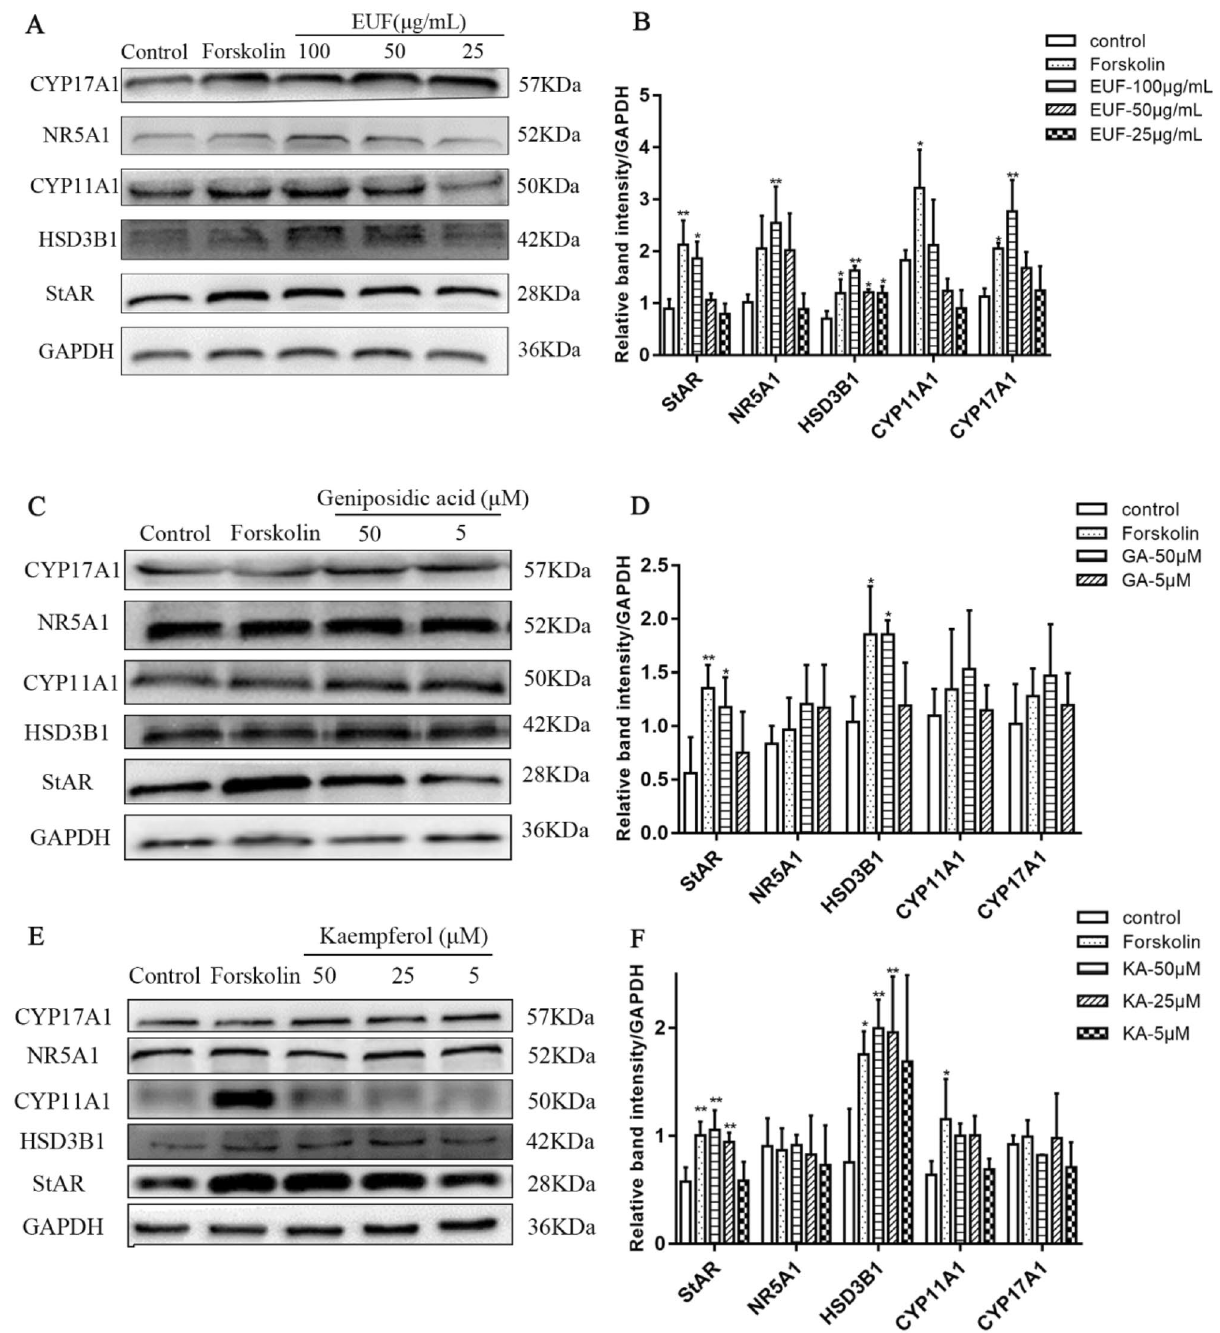
Figure 3. Effects of EUF extract ( A , B ), geniposidic acid ( C , D ), and kaempferol ( E , F ) on the protein expression of the steroidogenic enzyme in Leydig cells. * P < 0.05 versus the controls: ** P < 0.01 versus the controls. EUF, E. ulmoides staminate HSD3B1. As an inhibitor of adenylyl cyclase, SQ22536 down-regulates the synthesis of cAMP and then inhibits the activities of testosterone biosynthesis-related proteins such as StAR and NR5A1 27 . H89 could inactivate PKA